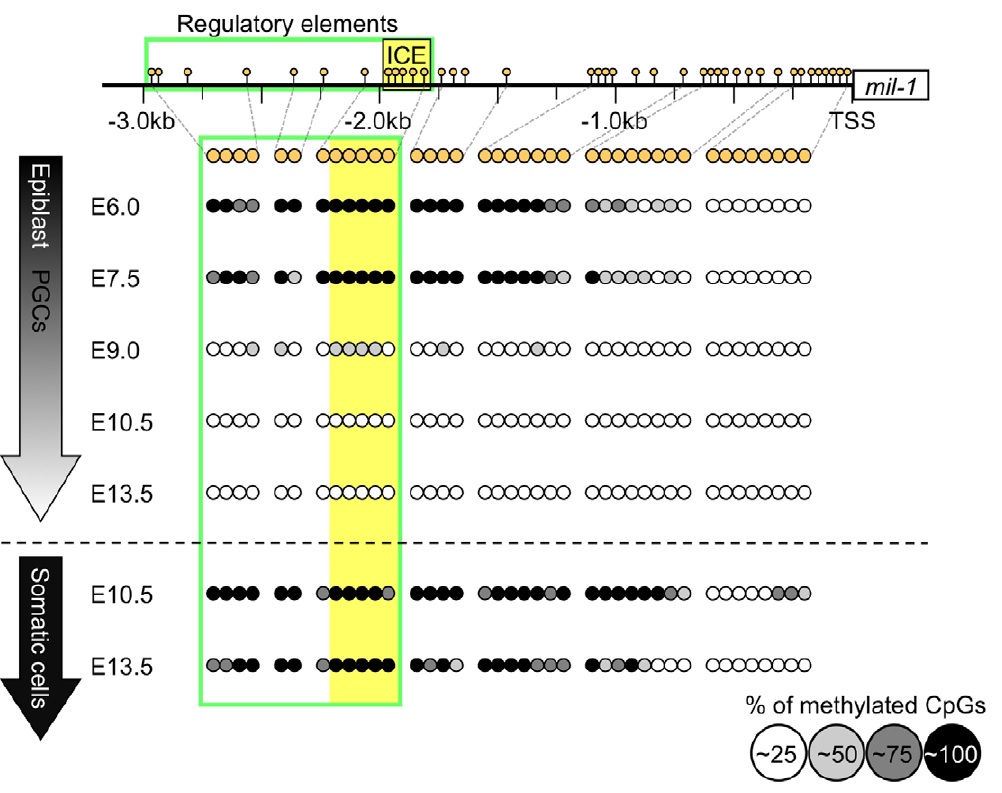
Figure 1. The regulatory region of mil-1 becomes hypomethylated during PGC development. Bisulfite sequencing analysis of the regulatory region of mil-1 was performed using epiblasts, PGCs/somatic cells purified as GFP positive/negative cells from embryos at each embryonic day (E). The rectangle containing mil-1 in the top line represents an exon, and the numbers with ‘kb (kilobase)’ under the line indicate distance from the transcription start site (TSS). The box outlined in green represents the regulatory element required for PGC-specific expression and the Ifitm genes consensus element (ICE) is shown in more detail in Figure 4A. Each circle corresponds to a CpG site in the regulatory region, and the degree of gray in each circle corresponds to the level of DNA methylation.